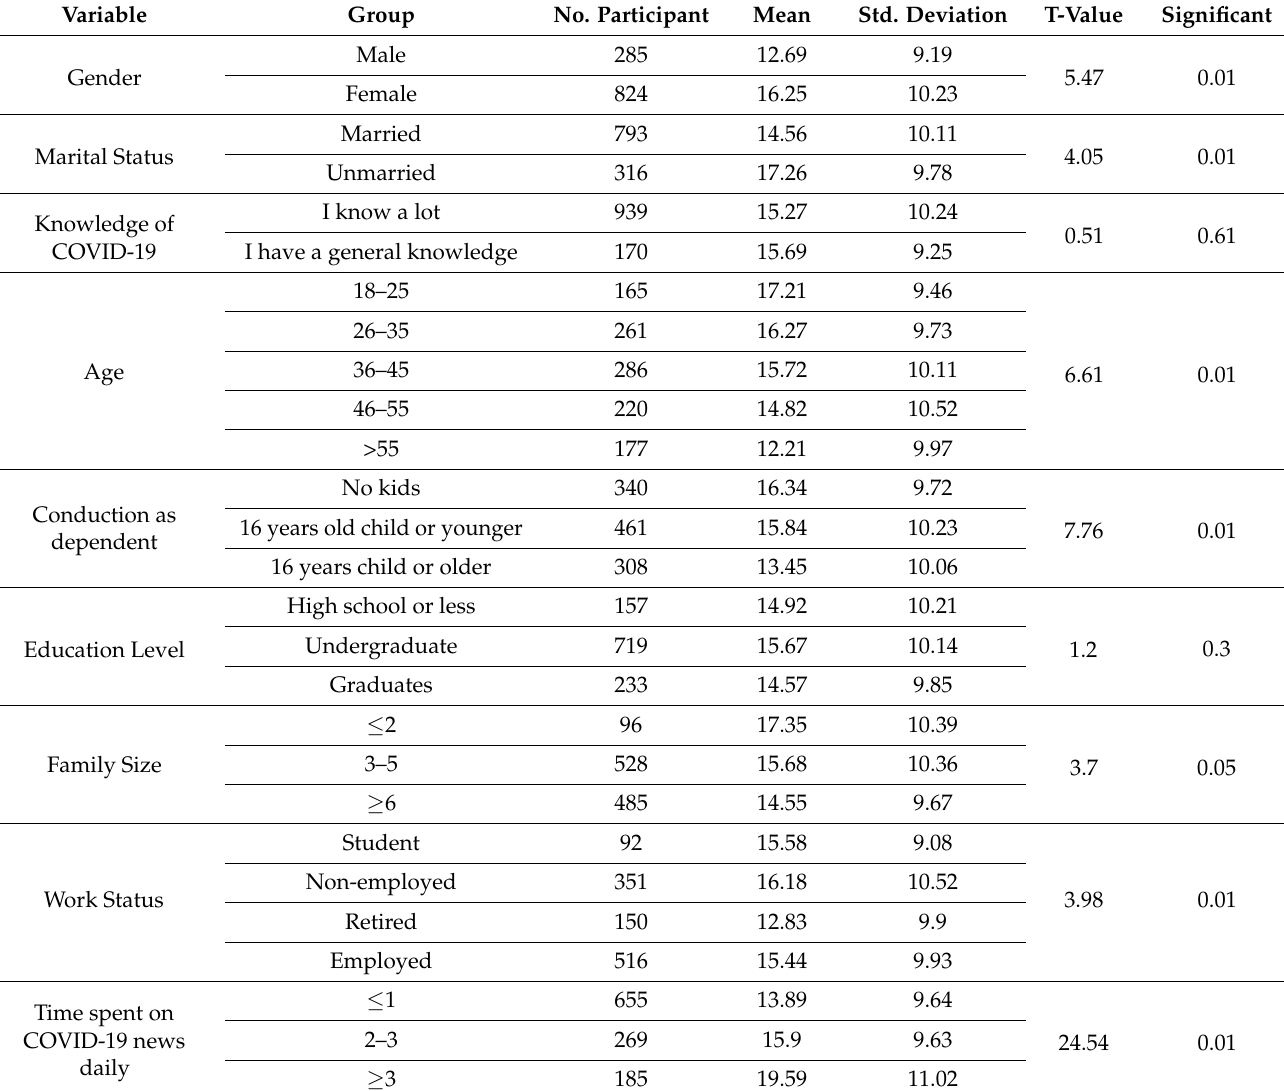
Table 4. The CES-D score (mean, SD) for depression in different sociodemographic groups and the p value of ANOVA indicating the significant effect of the